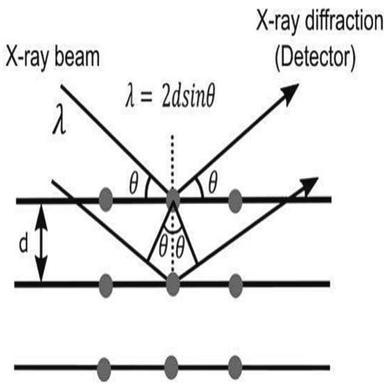
Schematic highlighting important general features being the basis for the energy-dispersive X-ray diffraction method for determining residual stresses based on the Bragg's law. The schematic has been inspired by.